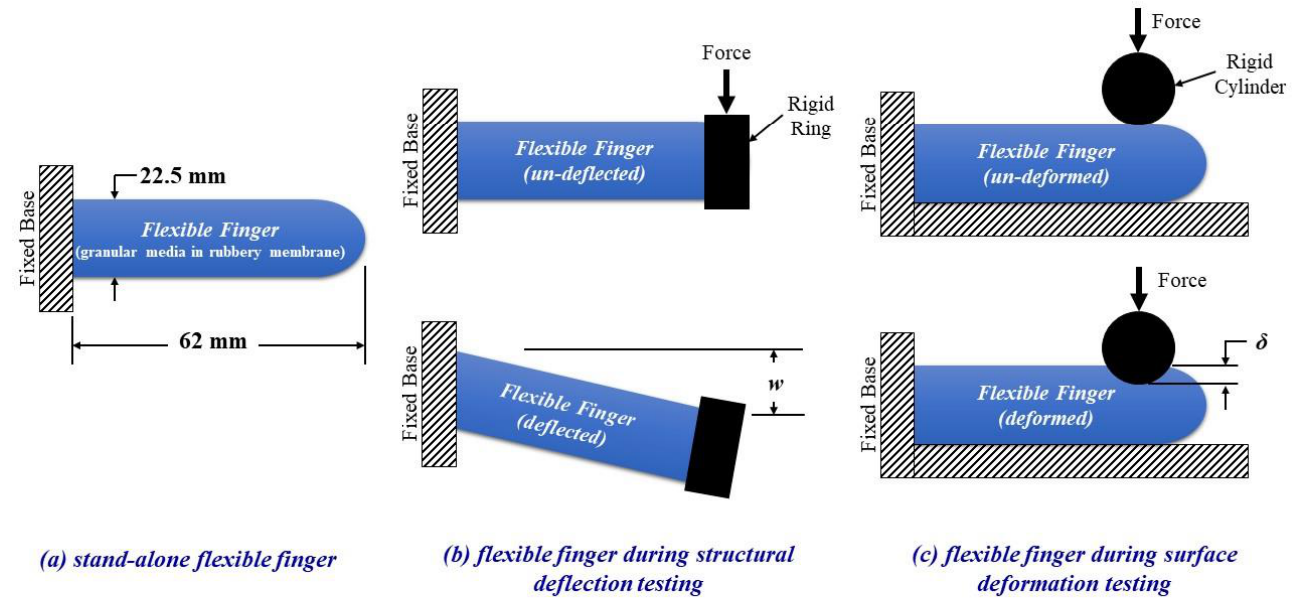
Figure 1. ( a ) Geometric configuration of flexible finger with granular media and elastic membrane, ( b ) representation of the structural testing to find the force–deflection data, and ( c ) surface contact testing to report force–deformation behavior.